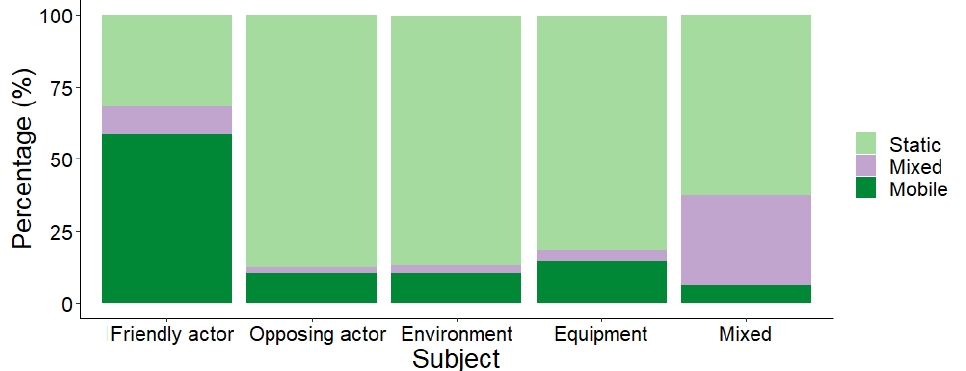
Figure 24. Deployment distribution between node mobility and deployment